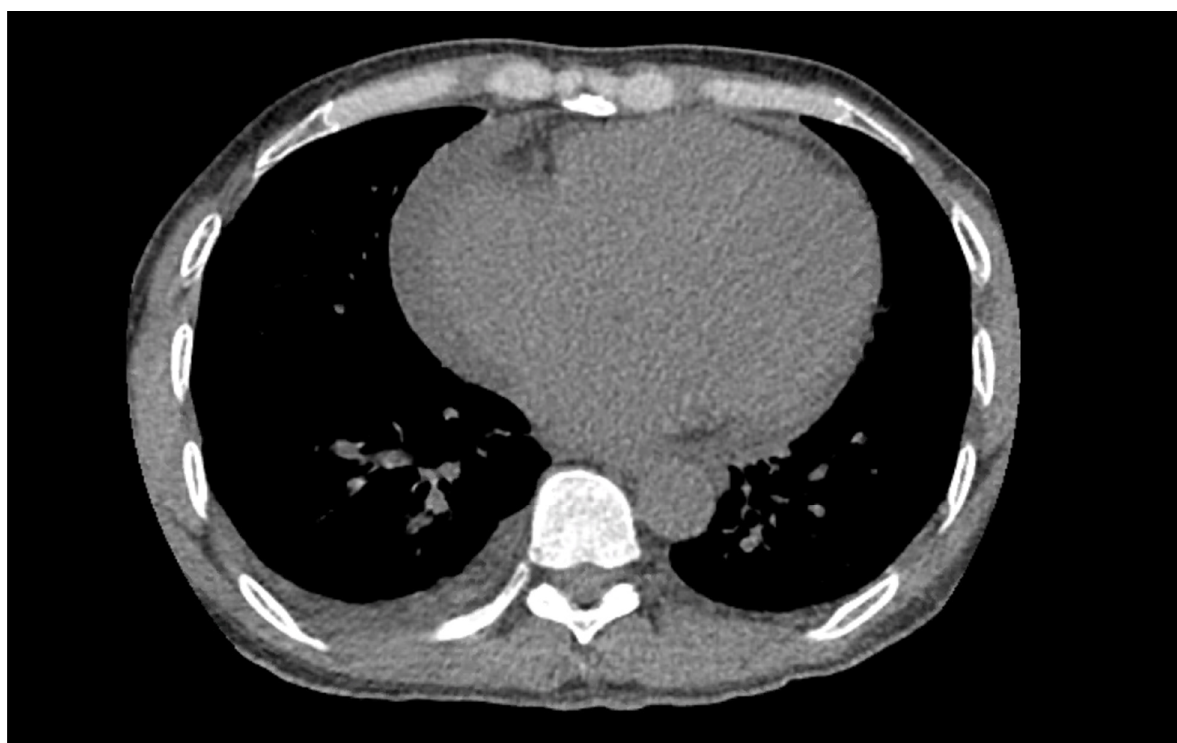
Figure 3. Segment of computed tomography (CT) of the thorax demonstrating cardiomegaly.